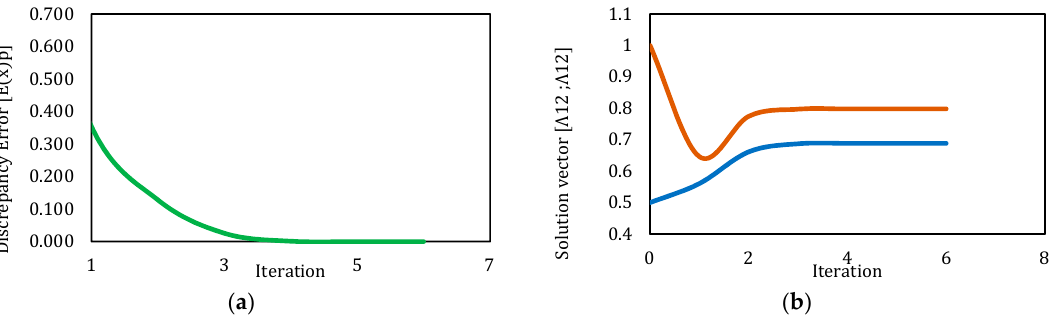
Figure 3. Behavior of discrepancy error and solution vector for Newton’s method-simulation 3. ( a ) Behavior of discrepancy error respect to iterations. ( b ) Behavior of values for solution vector respect to iterations.